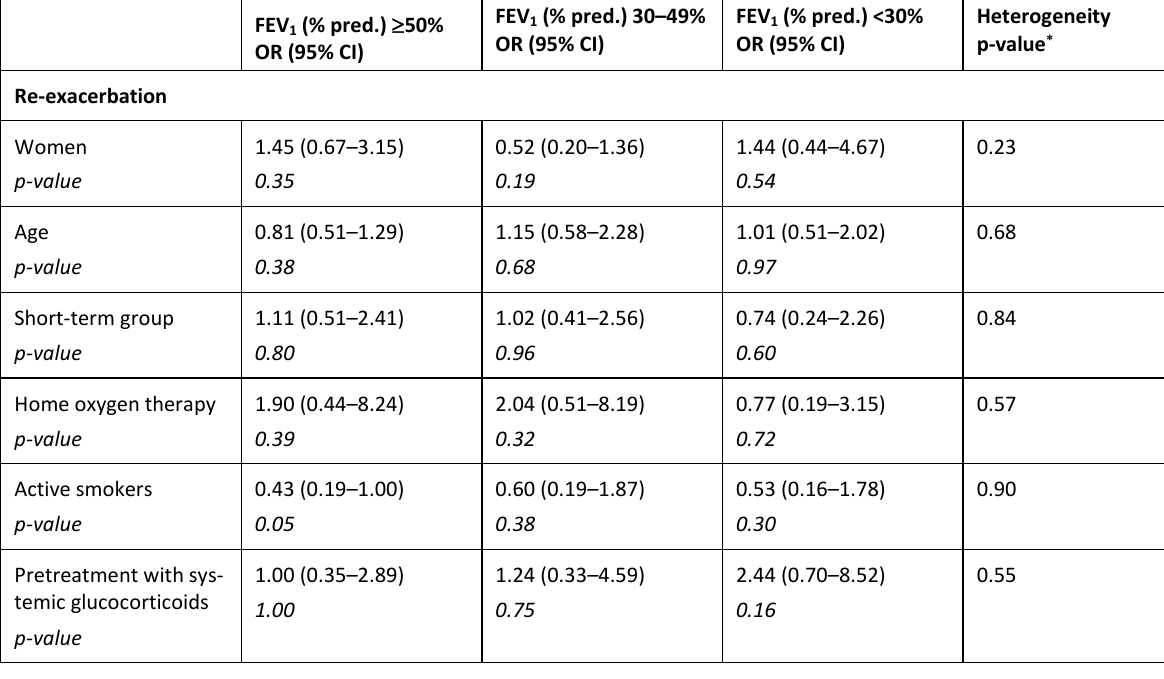
Table S3B: Multivariate analysis of re-exacerbation or re-exacerbation and/or death stratified by FEV 1 at